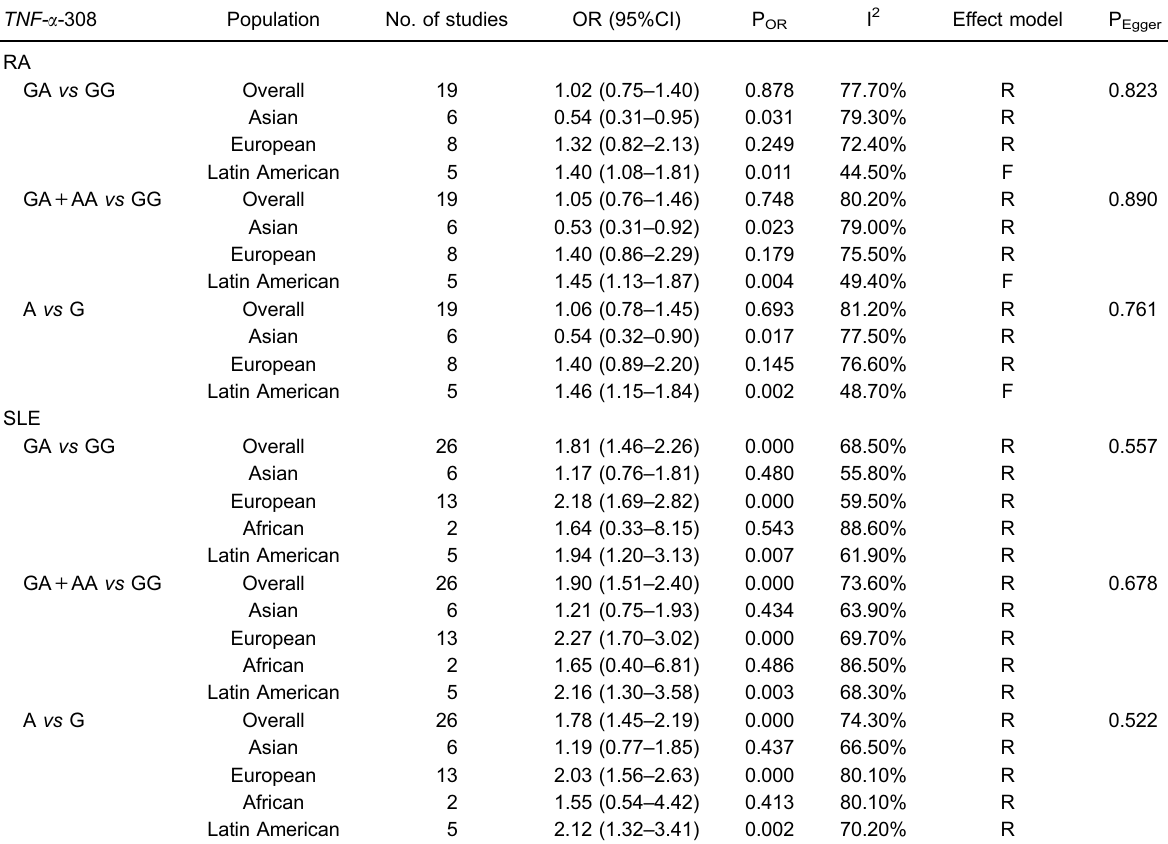
Table 2. Summary of pooled odds ratio (OR) and 95% con fi dence interval (CI) for the association of TNF- a -308 single-nucleotide polymorphisms with rheumatoid arthritis (RA) and systemic lupus erythematosus